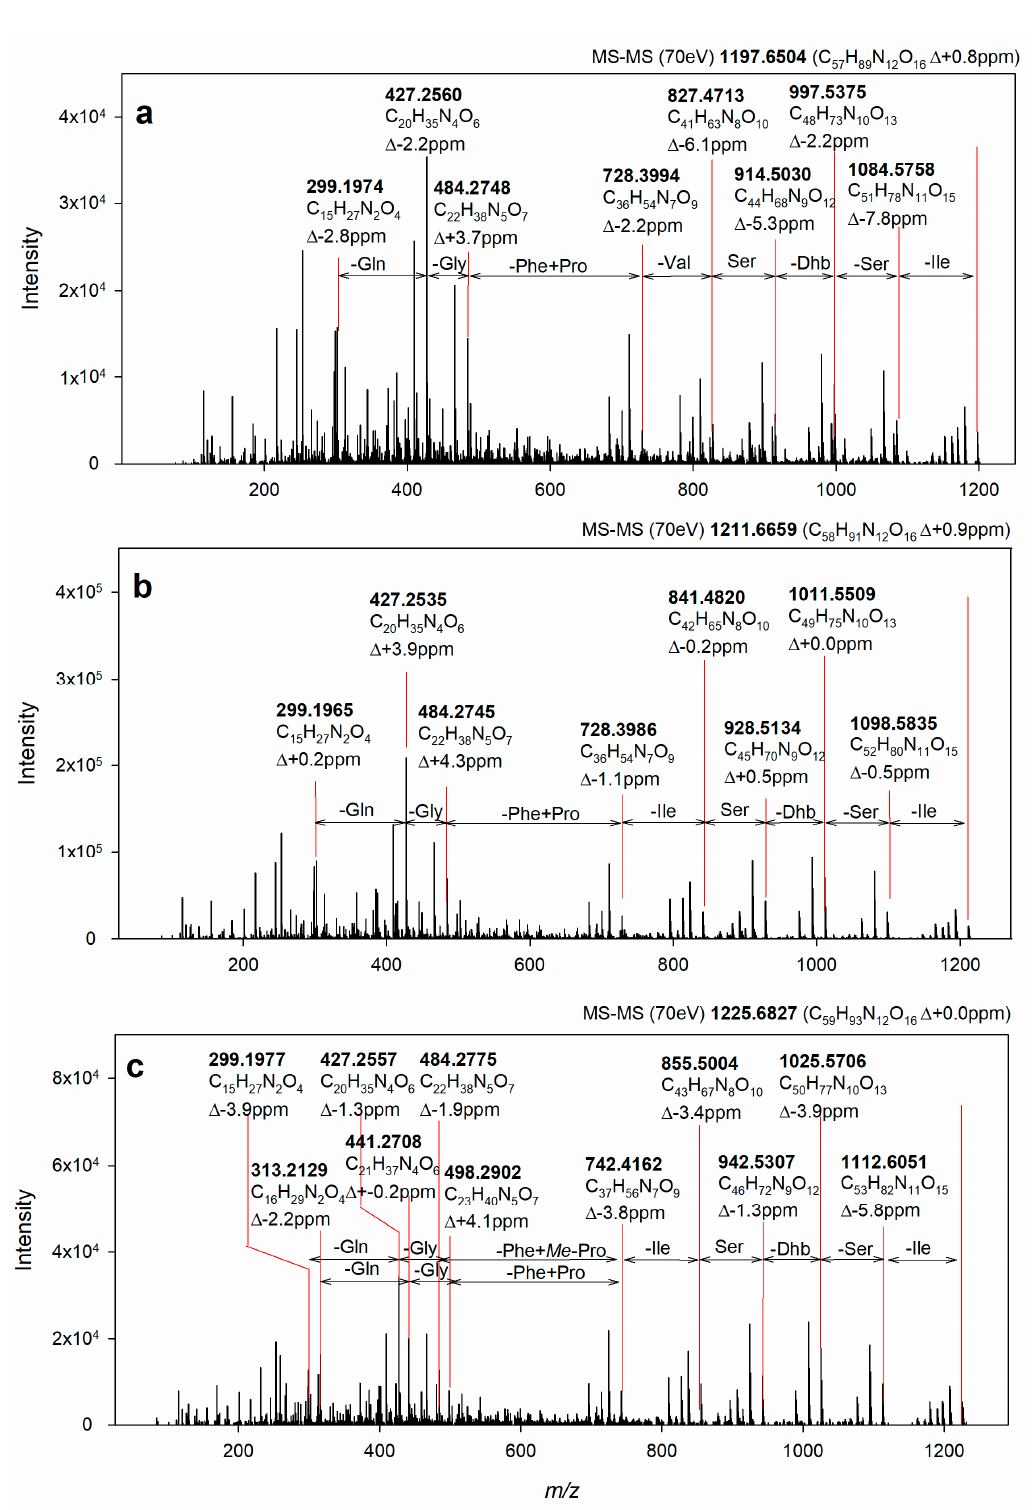
Figure 5. ESI-HRMS/MS spectra of isolated compounds 1 ( a ), 2 ( b ), and 3 ( c ). The HRMS/MS analysis confirmed the identity of the compounds 2 and 3 as muscotoxin A and muscotoxin B, respectively. Compound 1 was identified as novel muscotoxin variant (muscotoxin C) based on ESI-HRMS/MS and NMR data. The sum formulas and mass error are shown for individual fragment